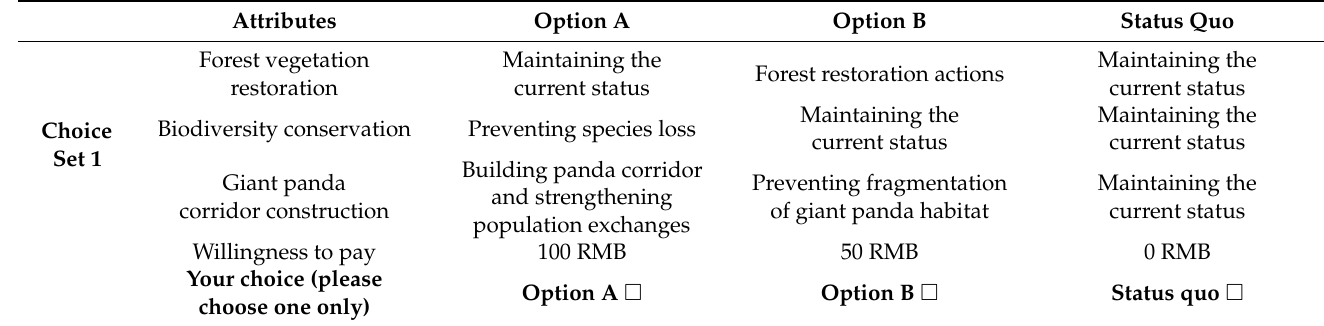
Table 2. Choice set example.